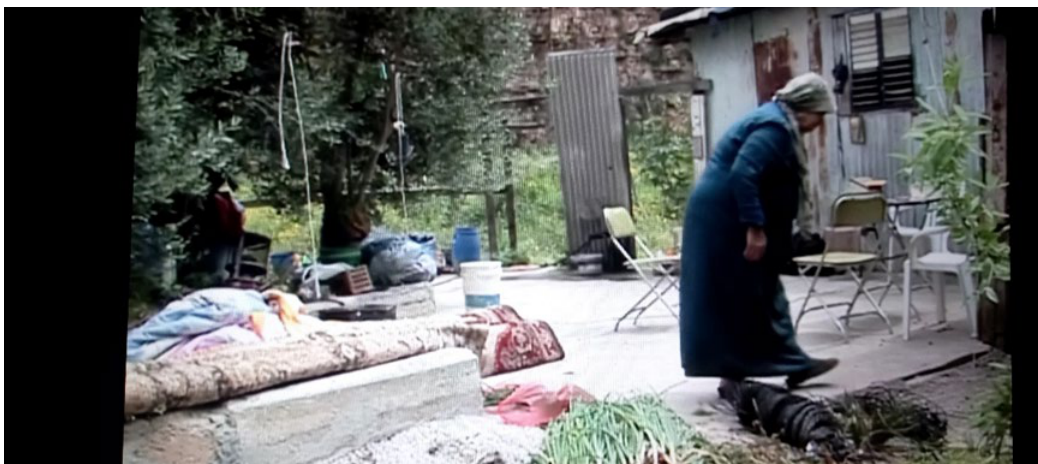
Figure 9 Amna in the courtyard of the shack, Source: 'Roshmia', Salim Abi-Jabel, 2015